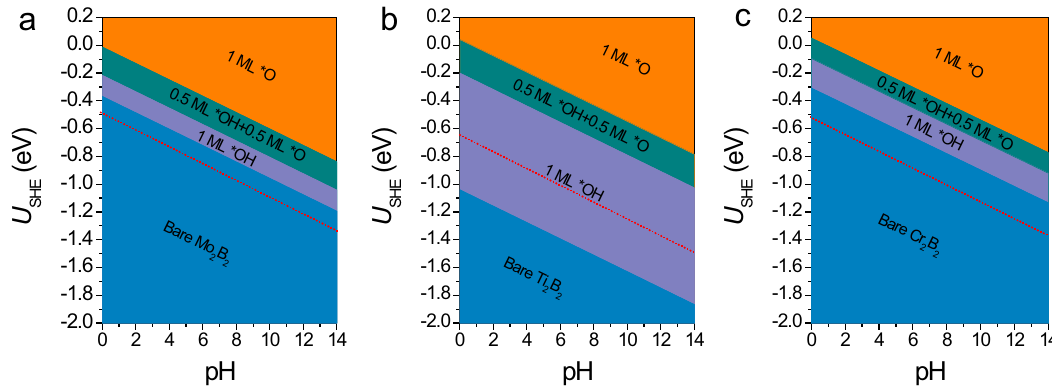
Fig. 5 Surface states of MBenes under electrochemical conditions. Surface Pourbaix diagrams of 2D ( a ) Mo 2 B 2 , ( b ) Ti 2 B 2 , and ( c ) Cr 2 B 2 . The thermodynamically stable states of the surface under SHE and pH values are highlighted by orange (for *O), green (for *O + *OH), and purple (for *OH). The red dashed line represents the limiting potential of urea formation.